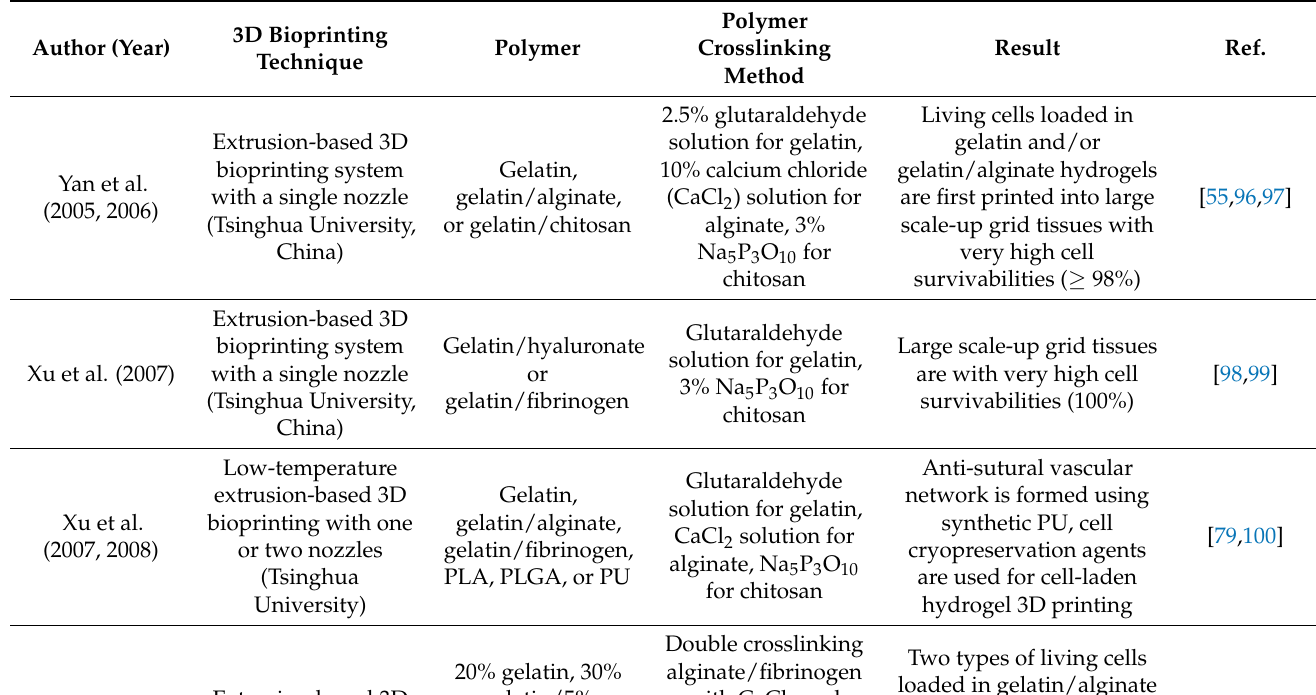
Table 1. Outstanding 3D bioprinting technologies and polymers for bioartificial organ engineer-